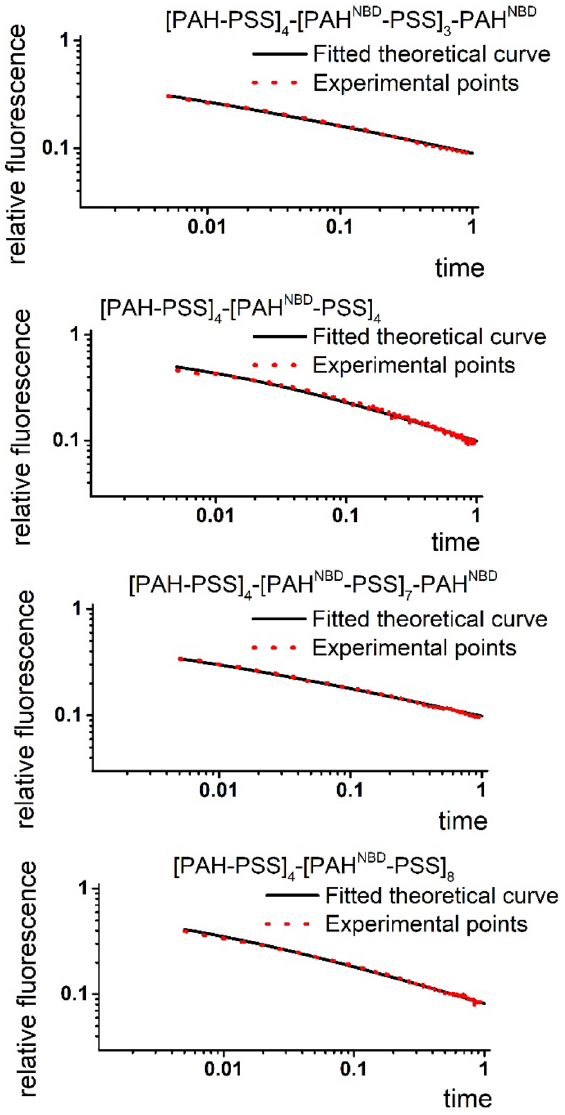
Figure 3. The fitting of experimental data with theoretical curve in log–log scale for [PAH-PSS] 4 -[PAH NBD -